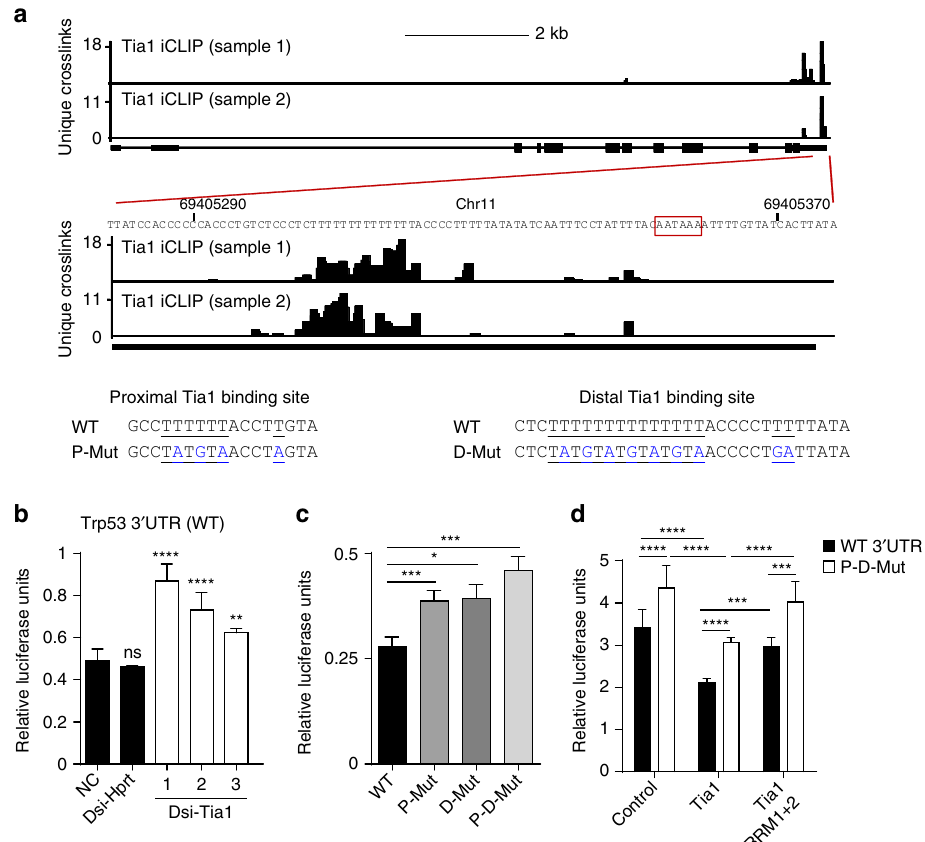
Fig. 5 Tia1 binding to p53 mRNA silences p53 mRNA translation. a Map of Tia1-binding sites across the Trp53 gene locus. Tia1 binding to the 3 ′ terminal sequence of p53 3 ′ UTR is magni fi ed. Red box highlights p53 polyadenylation site. Data from two iCLIP experiments. Bottom panels show the nucleotide sequence of the proximal (closest to p53 stop codon) and the distal (closest to the polyadenylation site) U-rich Tia1 binding sites. Nucleotides in blue were substituted by site-directed mutagenesis for functional characterization. b Translation analysis of a renilla luciferase reporter construct containing the p53 3 ′ UTR (psiCkeck2- p53 3 ′ UTR) after knock down of Tia1 with three different DsiRNAs. A scramble DsiRNA was used as negative control. A Dsi-Hprt was used as positive control for cell transfection and gene knock down. Data from one of the three independent experiments performed are shown as relative luciferase units (RLU) (Mean + s.d., unpaired t -test, ** P < 0.01, *** P < 0.001, **** P < 0.0001). c Functional analysis of the distal (D) and proximal (P) Tia1 binding sites in p53 3 ′ UTR in mRNA translational regulation. RLU were quanti fi ed after 24-h transfection with a psiCkeck2- p53 3 ′ UTR (WT), psiCkeck2- p53 3 ′ UTR P-mutant (P-Mut), psiCkeck2- p53 3 ′ UTR D-mutant (D-Mut) or psiCkeck2- p53 3 ′ UTR P-D-mutant (P-D-Mut). Data from one of the fi ve independent experiments are shown (Mean + s.d.; unpaired t -test, * P < 0.05, *** P < 0.001). d Analysis of Tia1-dependent mRNA translational silencing. Cells were co-transfected with a psiCheck2-p53 3 ′ UTR (WT) or a psiCkeck2- p53 3 ′ UTR P-D-mutant (P-D-Mut) plasmid in combination with a MIGR1- Tia1, MIGR1-Tia1 Δ RRM1 + 2 or MIGR1-empty control plasmid. Data from the two independent experiments performed are shown as mean RLU + s.d. (RLU = renilla luciferase units divided by fi re fl y luciferase units and normalized by the value from cells co-transfected with an empty vector) (Unpaired t- test, *** P < 0.001, **** P < inhibitor 4EGI-1 38 did not bock p53 protein synthesis upon treatment with etoposide or actinomycin D (Fig. 8a, b and Supplementary Fig. 6A). Expression of Ccnd2, a well-known target of eIF4E, was reduced by 3-fold indicating effective